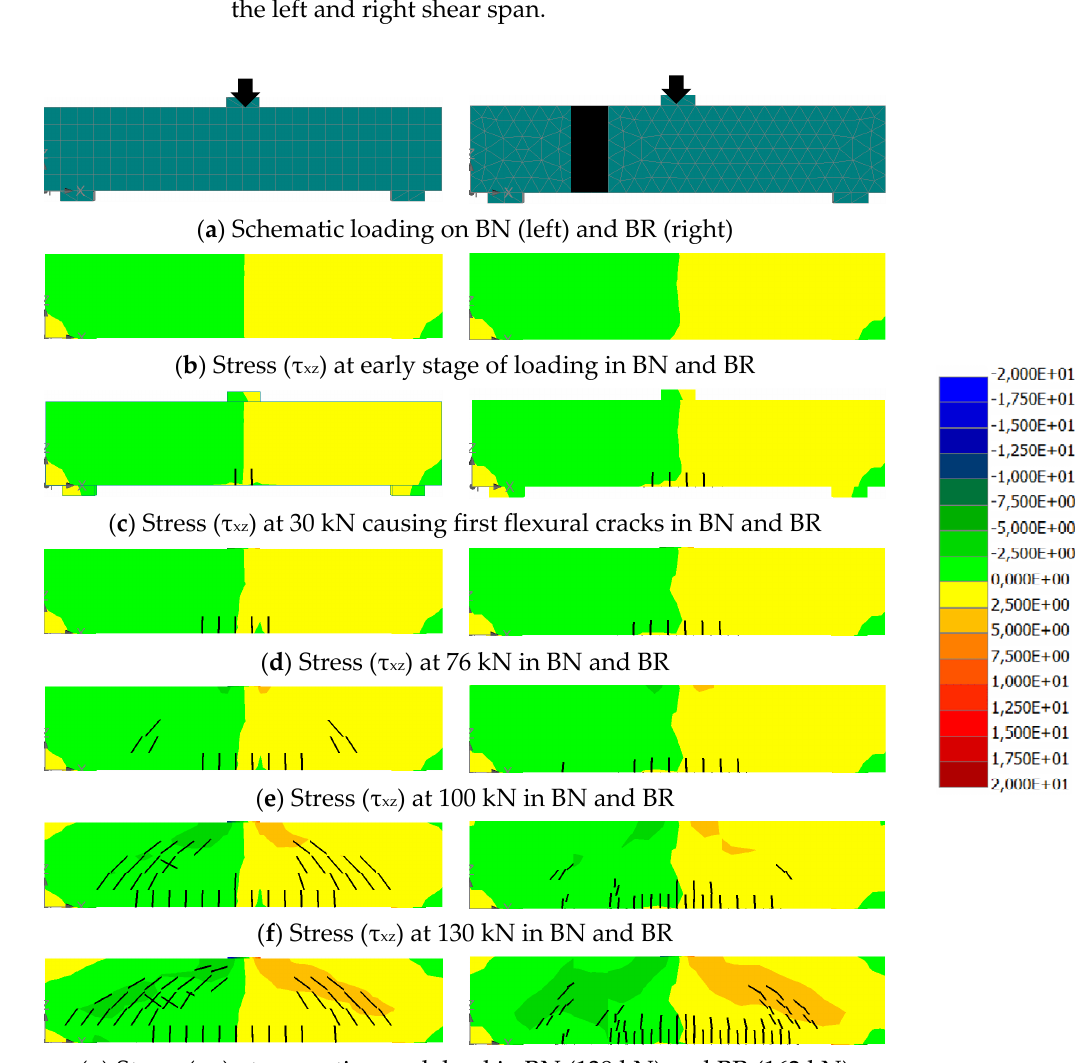
Figure 9. Shear stress ( τ xx ) distribution and cracks formation at various stages of loading.